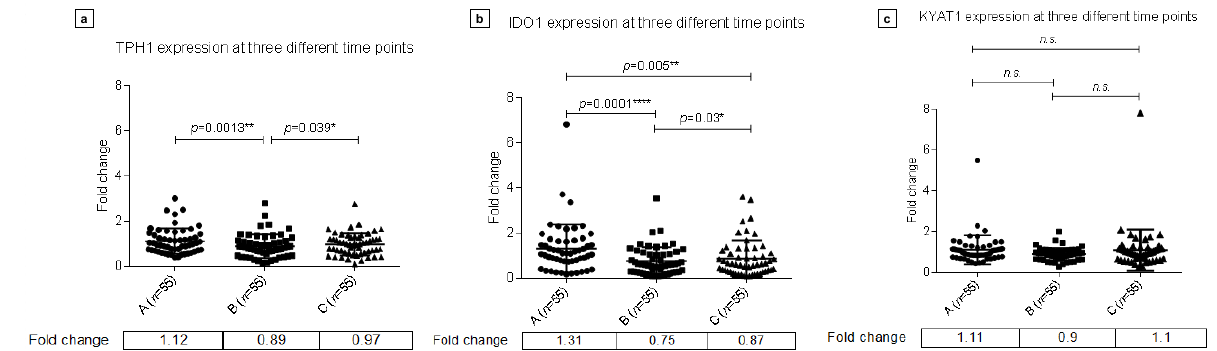
Figure 5. Changes in TPH1, IDO1 and KYAT1 mRNA levels during the course of ischemic stroke. Changes in TPH1 ( a ), IDO1 ( b ) and KYAT1 ( c ) mRNA levels in peripheral blood samples of ischemic stroke patients drawn before thrombolysis (A), in acut phase (B) and >10 h following thrombolysis (C). TPH1 expression is significantly lower in the acute phase following thrombolysis (B) compared to both before (A) and >10 h following treatment (C). IDO1 is significantly up-regulated in samples collected prior to thrombolytic therapy (A) both in comparison with samples obtained in the acute (B) and subacute phase (C) following intervention. No significant difference is detectable in KYAT1 mRNA levels by comparing samples in different time points during the course of the disease; p < 0.05; * p < 0.01; ** p < 0.001; **** p <